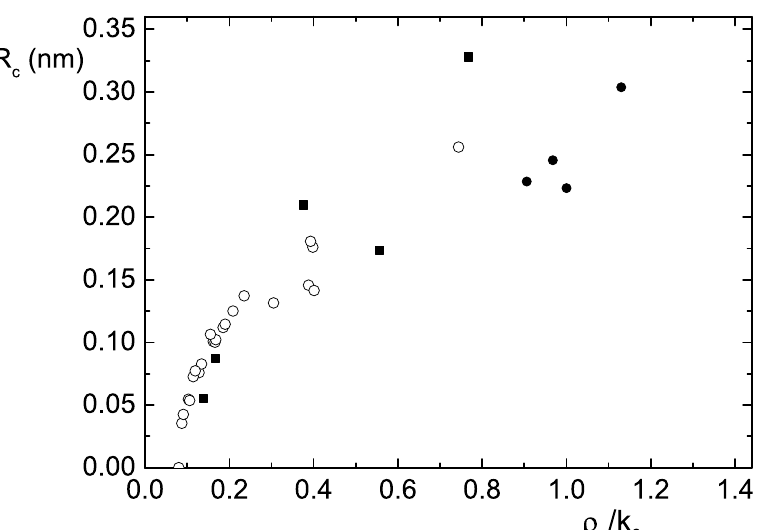
Figure 4. Plot of data on cavity radius R c versus the corresponding data on normalized electron density ρ e / k 0 . For sample materials considered in Table 1, black circles are used for samples respecting the intensity rule, and black squares for others. Sample materials in Table 2 are indicated by open